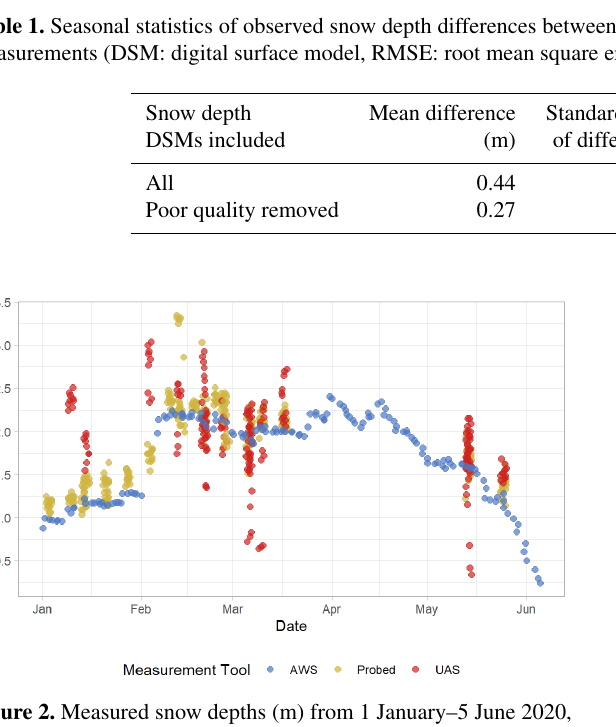
Table 1. Seasonal statistics of observed snow depth differences between probed and uncrewed aerial system (UAS)-derived validation point